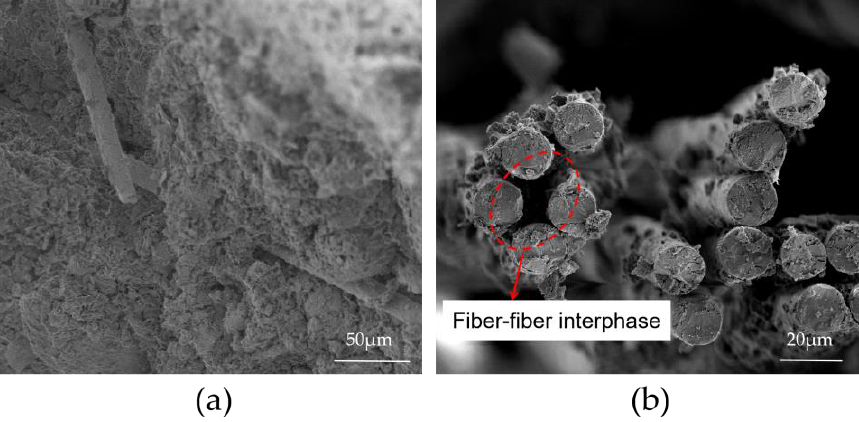
Figure 12. SEM images of different BFBCP specimens: ( a ) 0.6 BF9BCP; ( b ) 0.6 BF12BCP.